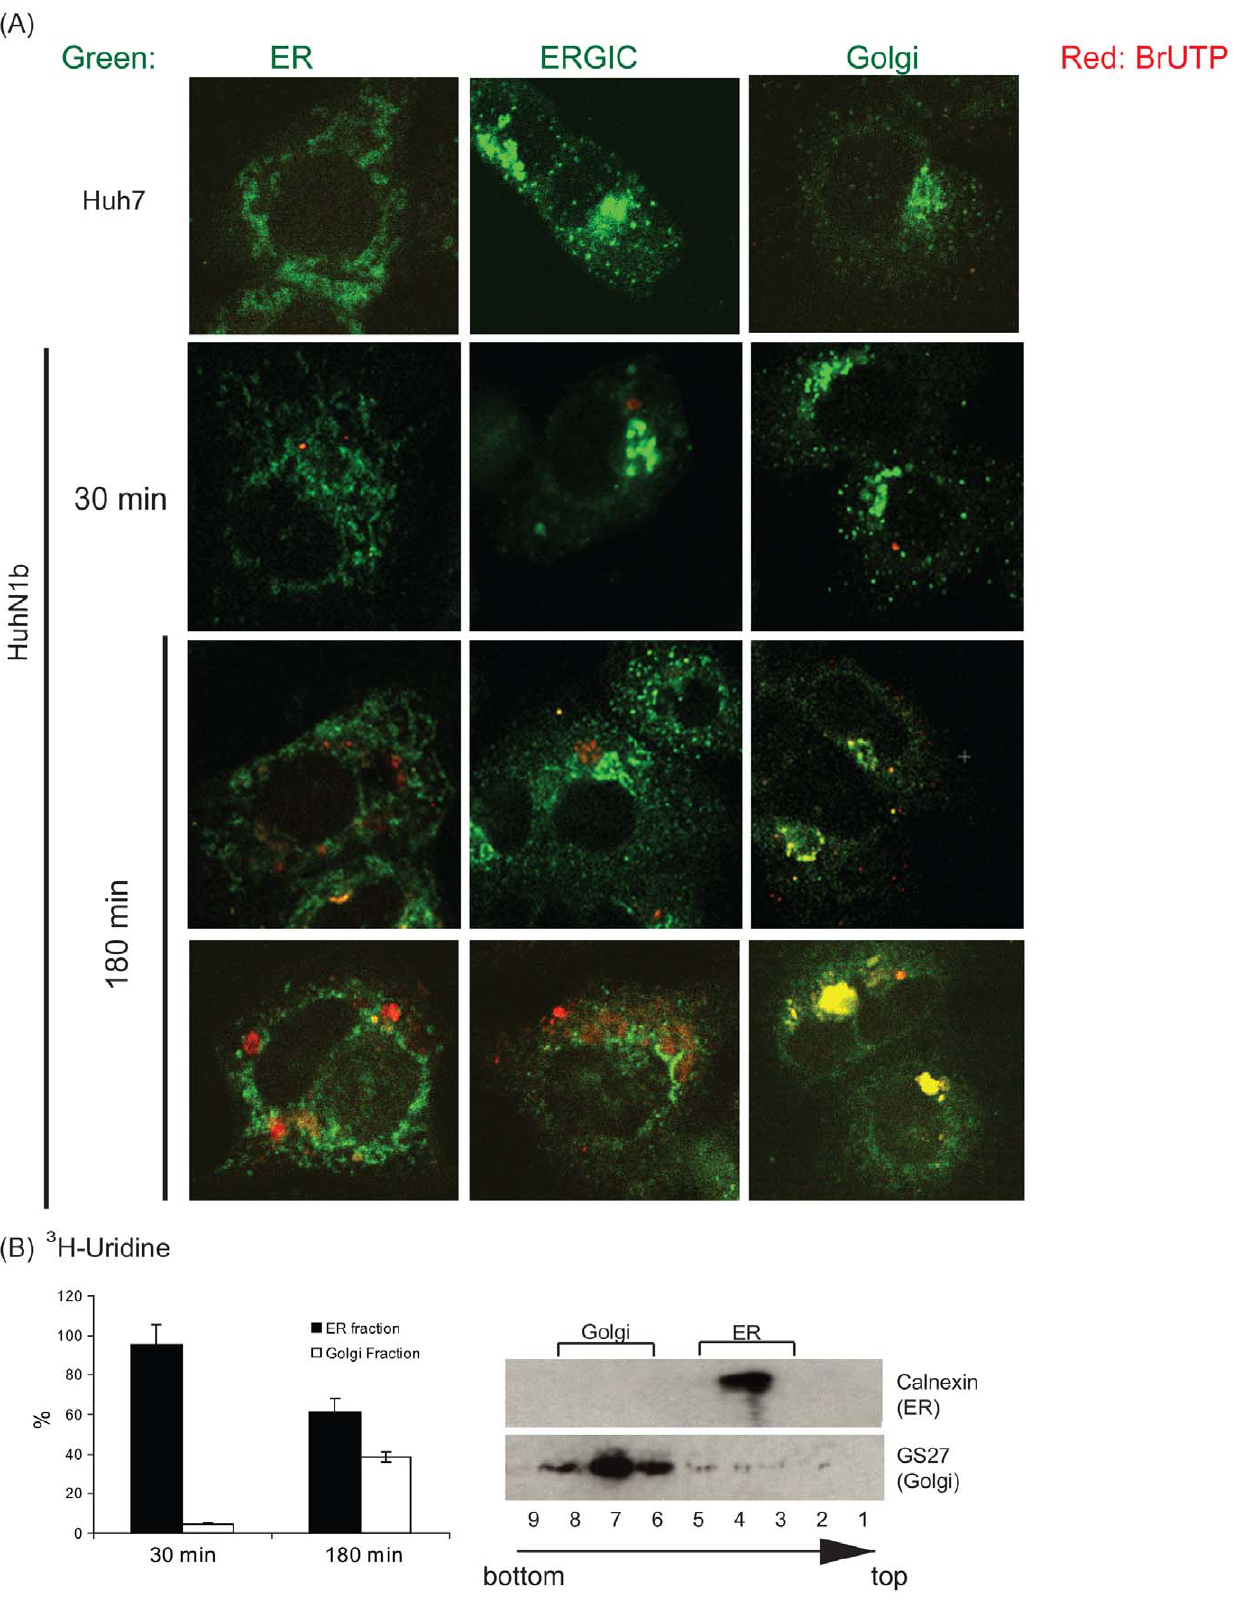
Figure 1. The translocation of newly-synthesized HCV RNA. HCV replicon cells were labeled with BrUTP (A) or 3 H-Uridine (B) in the presence of actinomycin D and chased for up to 180 minutes. (A) Immunofluorescence staining with anti-BrdU and other organelle antibodies shows the colocalization of BrU-labeled HCV RNA with ER initially (30 min) and then with Golgi (180 min). (B) Fractionation of ER and Golgi by sucrose gradient.